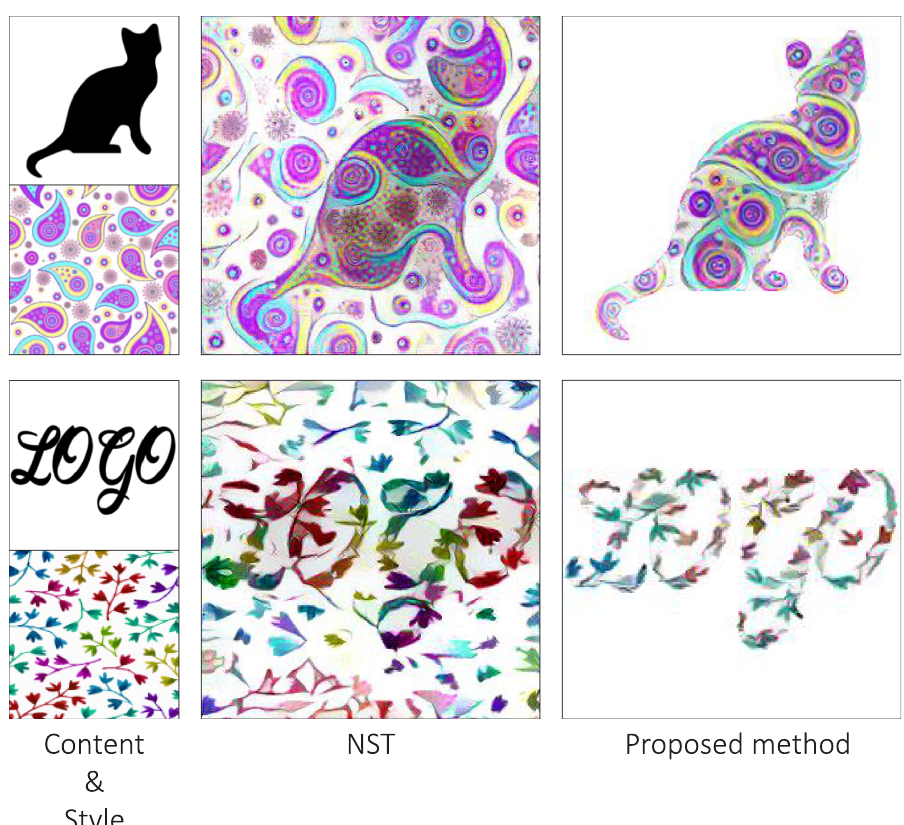
Fig 3. Examples of shape stylization. Compared to the NST, the proposed method was able to transfer the styles only to the foreground shape of the content image.